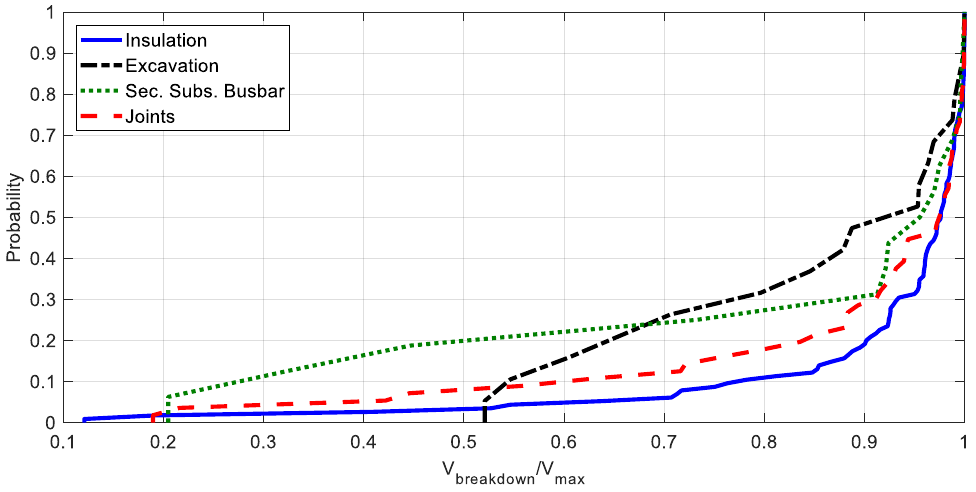
Figure 6. Observed cumulative probability for the voltage at the fault inception instant.